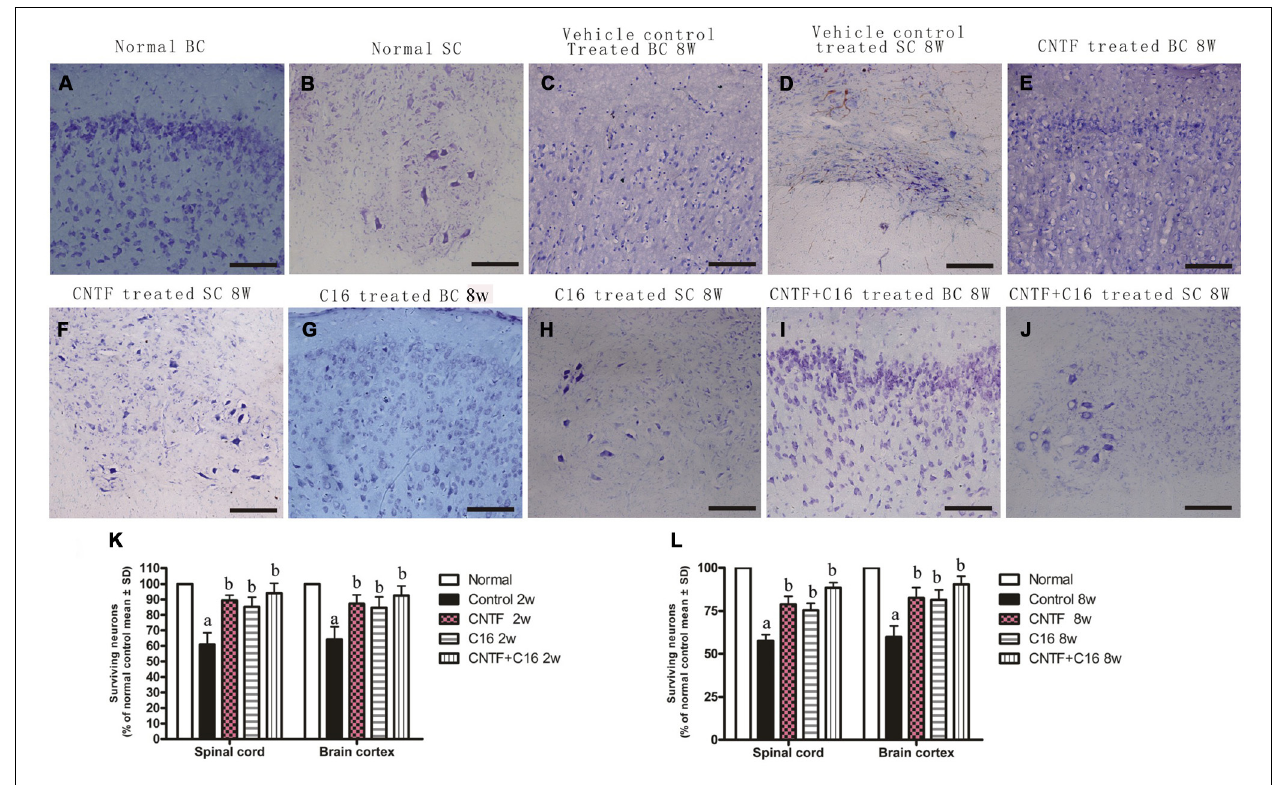
FIGURE 7 |Treatment with CNTF or C16 reduced the loss of neurons both in the spinal cord and brain. Nissl staining, bar = 100 μ m. [ (A,C,E,G,I) : coronal sections of brain motor cortex; (B,D,F,H,J) : traverse sections through anterior horn of lumbar spinal cord]. At week 8 post-immunization, normal animals (A,B) , vehicle-treated EAE rats (C,D) , CNTF-treated EAE rats (E,F) , C16-treated EAE rats (G,H) , and C16 + CNTF-treated EAE rats (I,J) . (K,L) The CNTF-, C16-, and C16 + CNTF- treated EAE rats all gained more neurons in the motor cortex, and